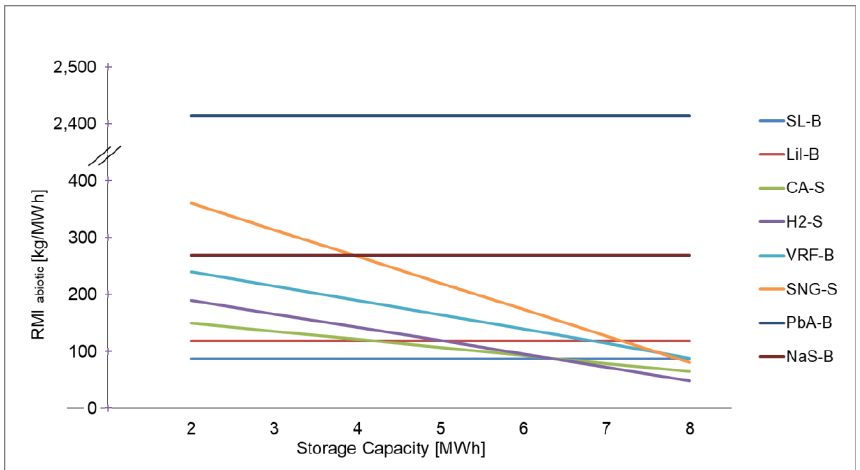
Figure 8. Change in the raw material input abiotic RMI abiotic per fed-out electricity for increasing storage capacity of electrical energy storage technologies from 2 to 8 MWh.